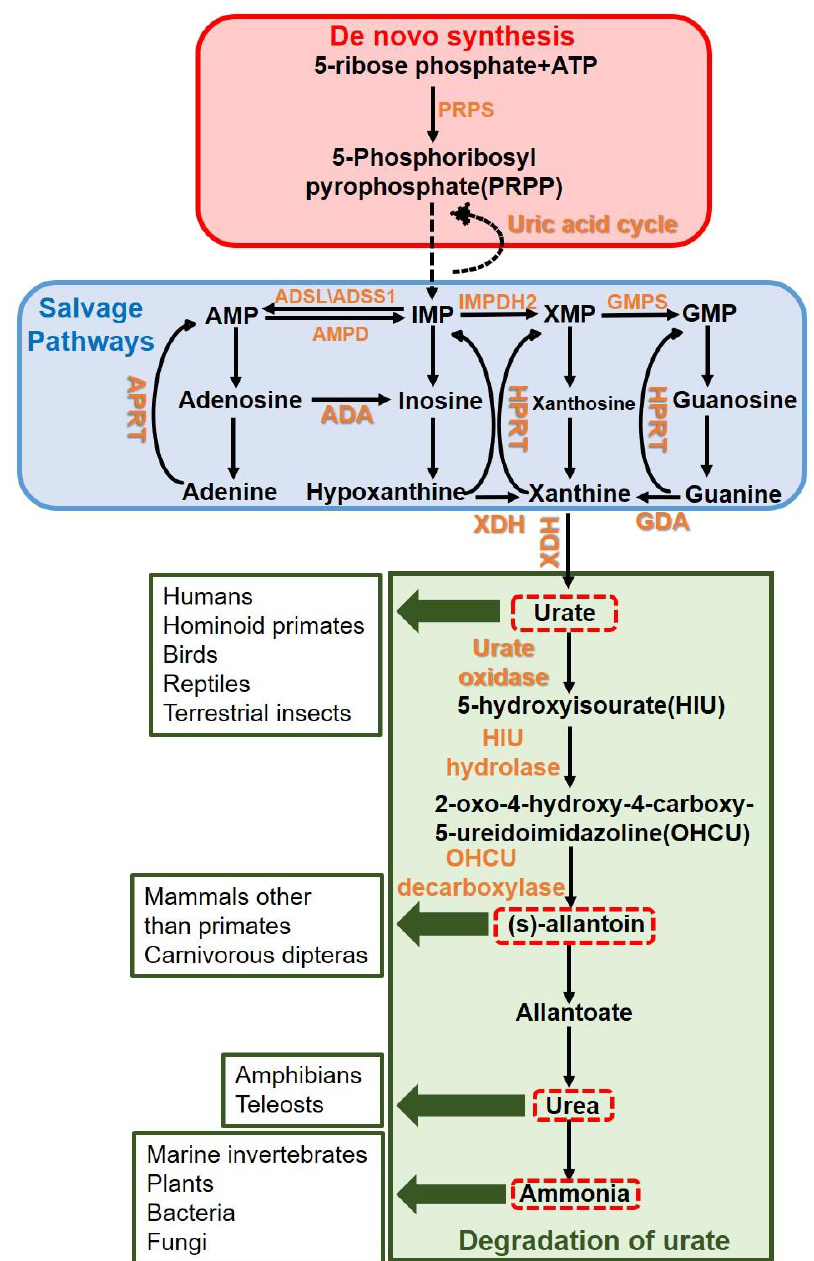
Figure 1. Purine metabolism and urate degradation in different species. Purine metabolism consists of de novo synthesis and salvage pathways. Humans, hominoid primates, birds, reptiles, and terrestrial insects exhibit urate ammonotelism. Mammals other than primates and carnivorous dipteras exhibit allantoin ammonotelism. Amphibians and teleosts exhibit urea ammonotelism. Marine invertebrates, plants, bacteria, and fungi directly excrete ammonia. The arrow from PRPP to IMP means the reactions is complexed and need about 10 steps; the arrow from IMP to PRPP represents the uric acid cycle which is particularly belong to the birds, reptiles and insects; the red dotted boxes represent the four product of urate degradation; the green arrows represent the species which put the correspondence product as end product of urate degradation; the other arrows generally represent one step reaction. Urate is a weak acid that normally exists as monosodium urate (MSU) and has antioxidative abilities, which was needed in the evolution of humans thousands to millions of years ago